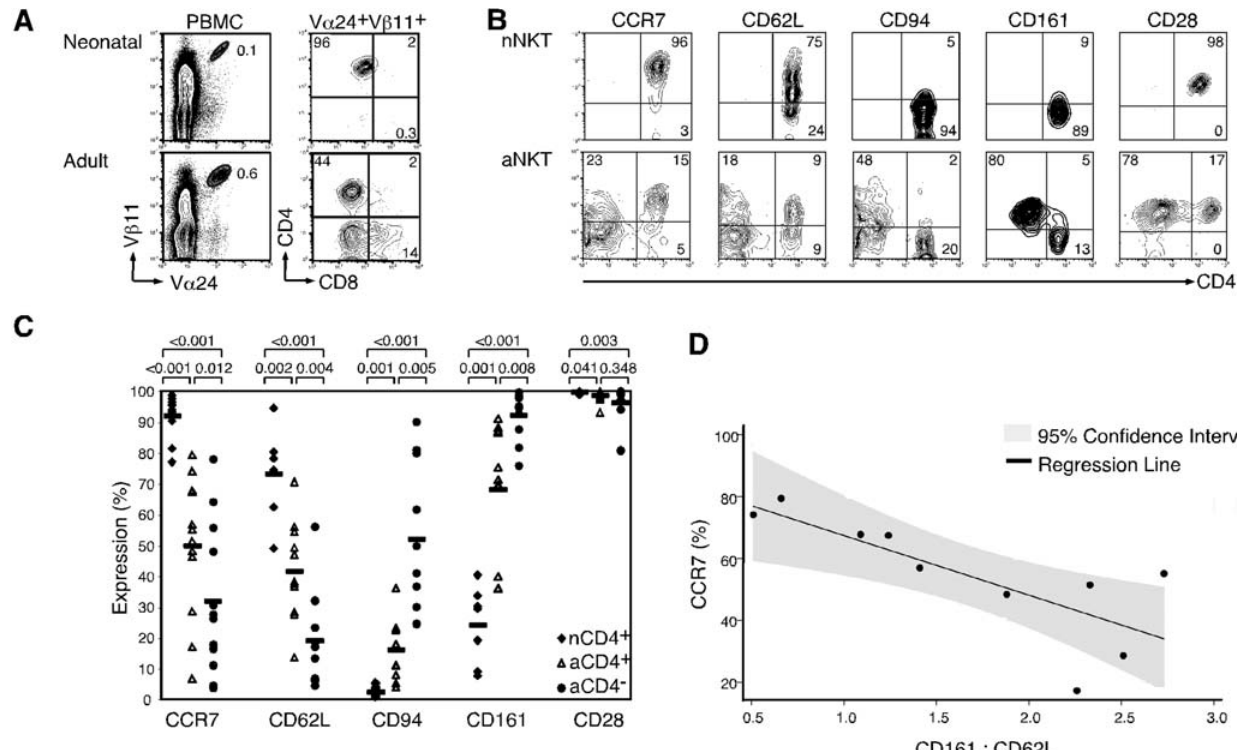
Figure 1. Identification of NKT cell subsets in neonatal and adult blood PBMC. (A) NKT cells in either neonatal or adult PBMC were identified by staining for the invariant TCR using antibodies against V a 24 (FITC) and V b 11 (unlabelled followed by goat anti-mouse APC). Double positive cells were identified as NKT cells and gated on for further analysis to determine CD4 (PE) and CD8 (biotin followed by strepavidin-PerCP-Cy5.5) expression. (B) NKT cell subsets were identified by staining for V a 24, V b 11, and CD4 as in 1A and then gated on for further analysis. Expression of the indicated cell surface marker on these subsets was then determined. Combinations of the following antibodies were used, depending on the particular stain: V a 24 (FITC or unlabelled), V b 11 (unlabelled or PE), CD4 (PE, biotin, or unlabelled), CCR7 (unlabelled), CD62L (PE), CD94 (unlabelled), CD161 (FITC), CD28 (biotin), goat anti-mouse (APC), and strepavidin (PerCP-Cy5.5). One representative donor is shown. (C) Summary of NKT cell phenotype data for all neonatal and adult donors. P values are indicated. For comparison of nCD4 + to either aCD4 + or aCD4 2 subsets, P values were generated using the Wilcoxon rank sum test. For comparison of aCD4 + to aCD4 2 subsets, P values were generated using the Wilcoxon signed rank test. (D) For CD4 + NKT cells of adult donors represented in 1C, the ratio of CD161 (% expression) to CD62L (% expression) was generated and compared to CCR7 expression using linear regression with a resulting equation of y= 2 19.277X + 86.676 and p=0.008.